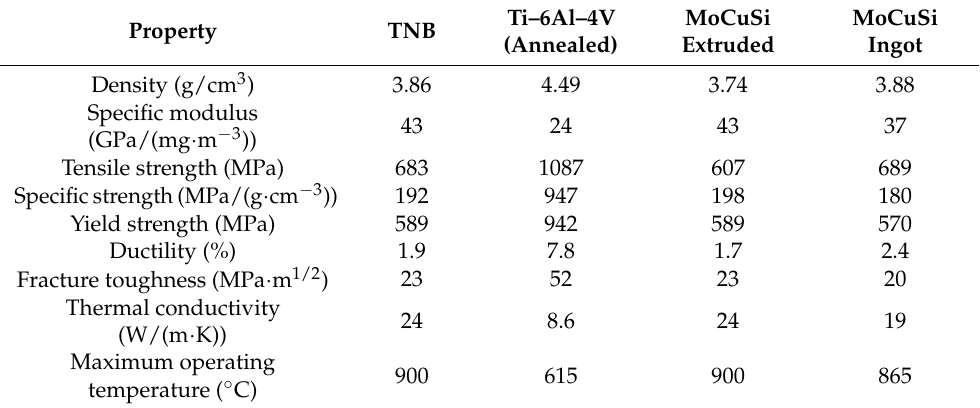
Table 1. Mechanical properties comparison between TiAl